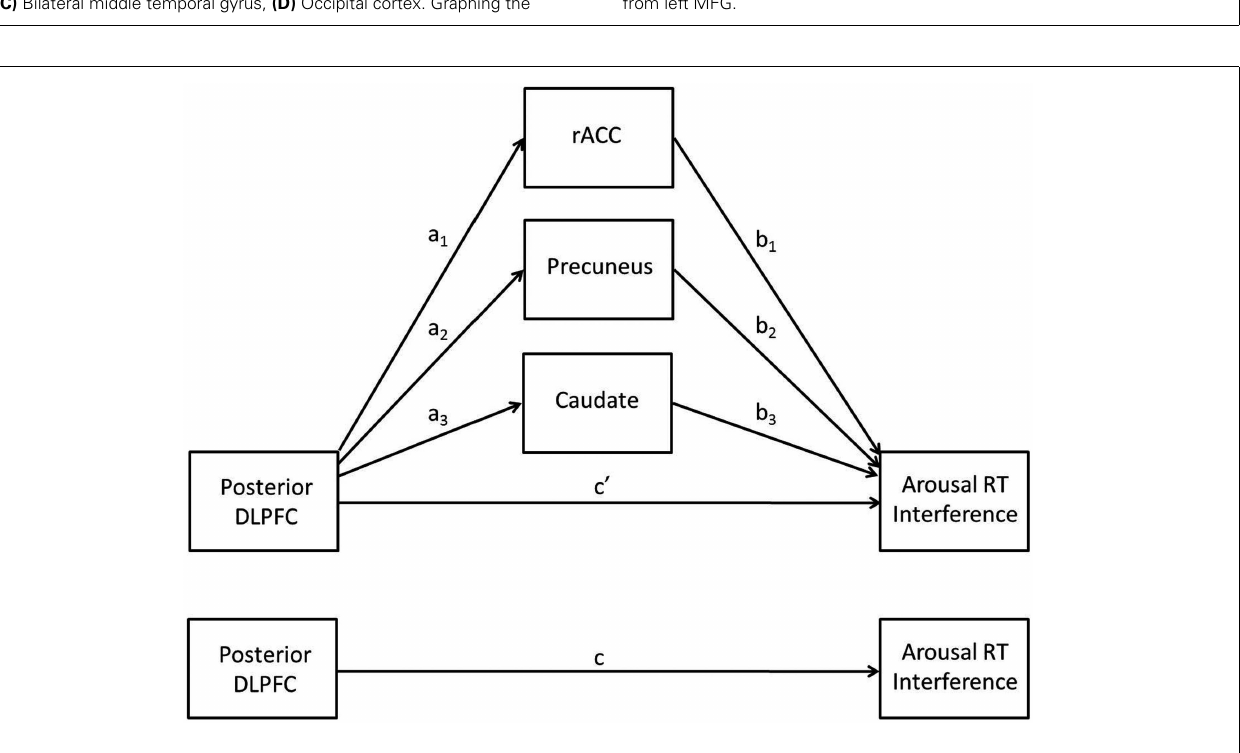
FIGURE 2 | Brain areas associated with the interaction between trait and state negative affect (NA). Blue = Less activation when both dimensions are high than when one dimension is high. L, left. Clusters of activation in (A) Left lateral middle frontal gyrus (MFG) and medial superior frontal gyrus, (B) Bilateral parietal cortex/occipital cortex, (C) Bilateral middle temporal gyrus, (D) Occipital cortex. Graphing the